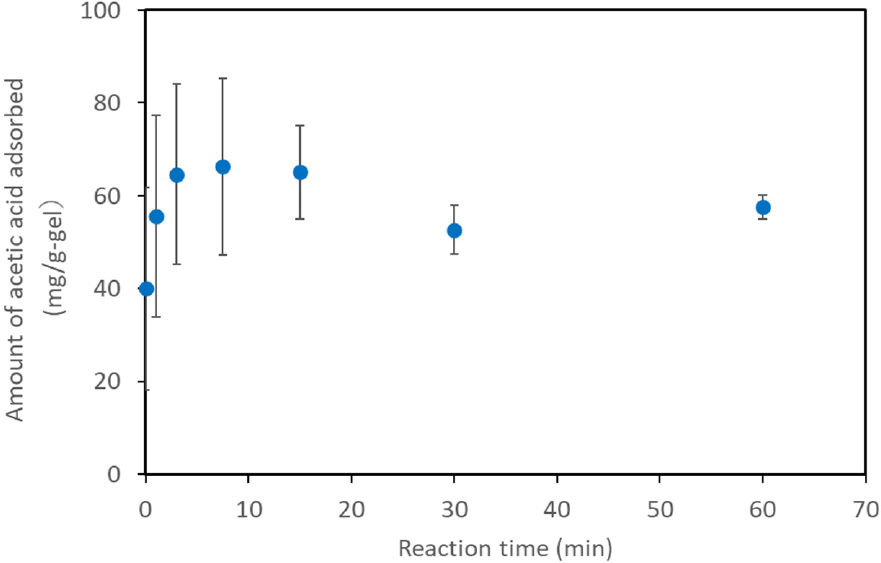
Figure 3. Relationship between the reaction time and amount adsorbed.